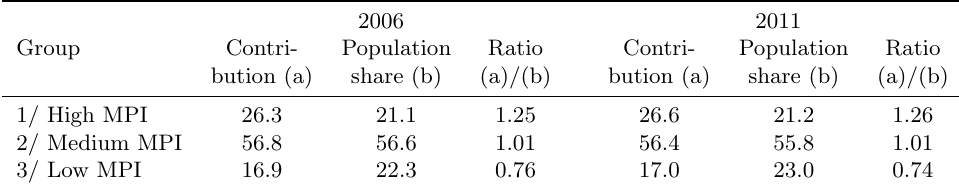
Table 8: Contribution (%) of each group to the overall regional